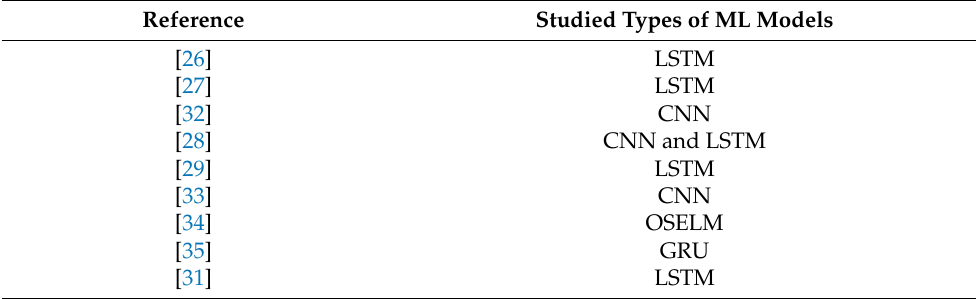
Table 2. Learning models used for complete and complex